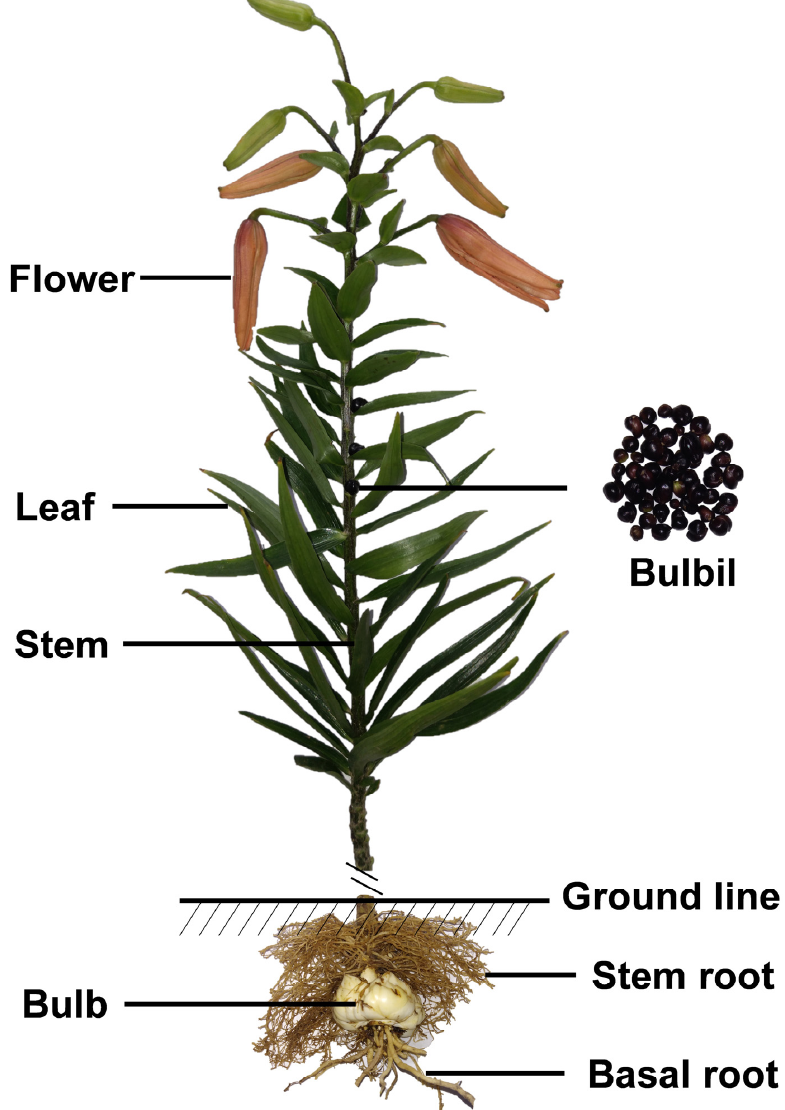
Figure 1. Whole plant of Lilium lancifolium. Note: the bulbil, as a special axillary vege tative reproductive organ, is only naturally produced in four wild lilies ( L. lancifolium , L. sulphureum , L. sargentiae , and L. bulbiferum ) and some A and LA